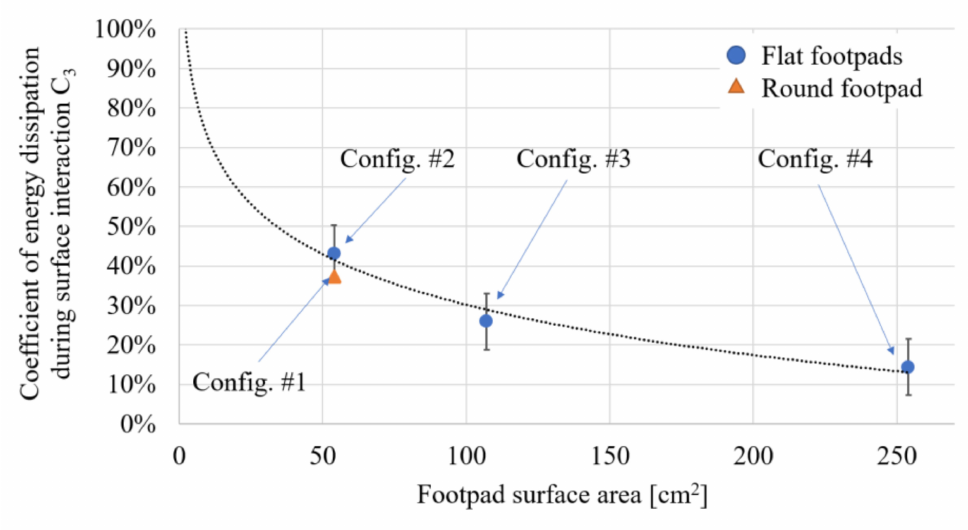
Figure 16. Dependence of the coefficient of surface energy dissipation against footpad surface area. The blue dots are results for configurations #2, #3 and #4. The orange triangle is a result for the rounded footpad (config. #1).